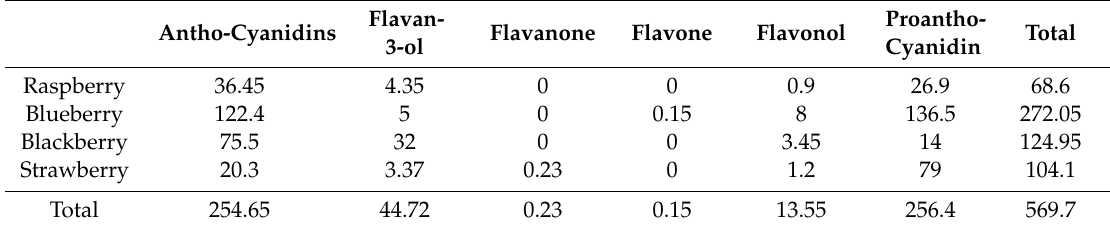
Table 2. Average flavonoid content mg / 75 g by flavonoid class and berry type